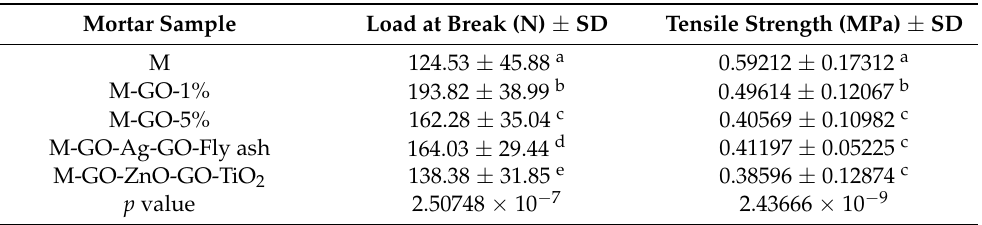
Table 3. Compression test results (following the Tukey test: groups of specimens marked with the same letter show no statistically significant differences between them; the groups marked with different letters show statistically significant differences between them).